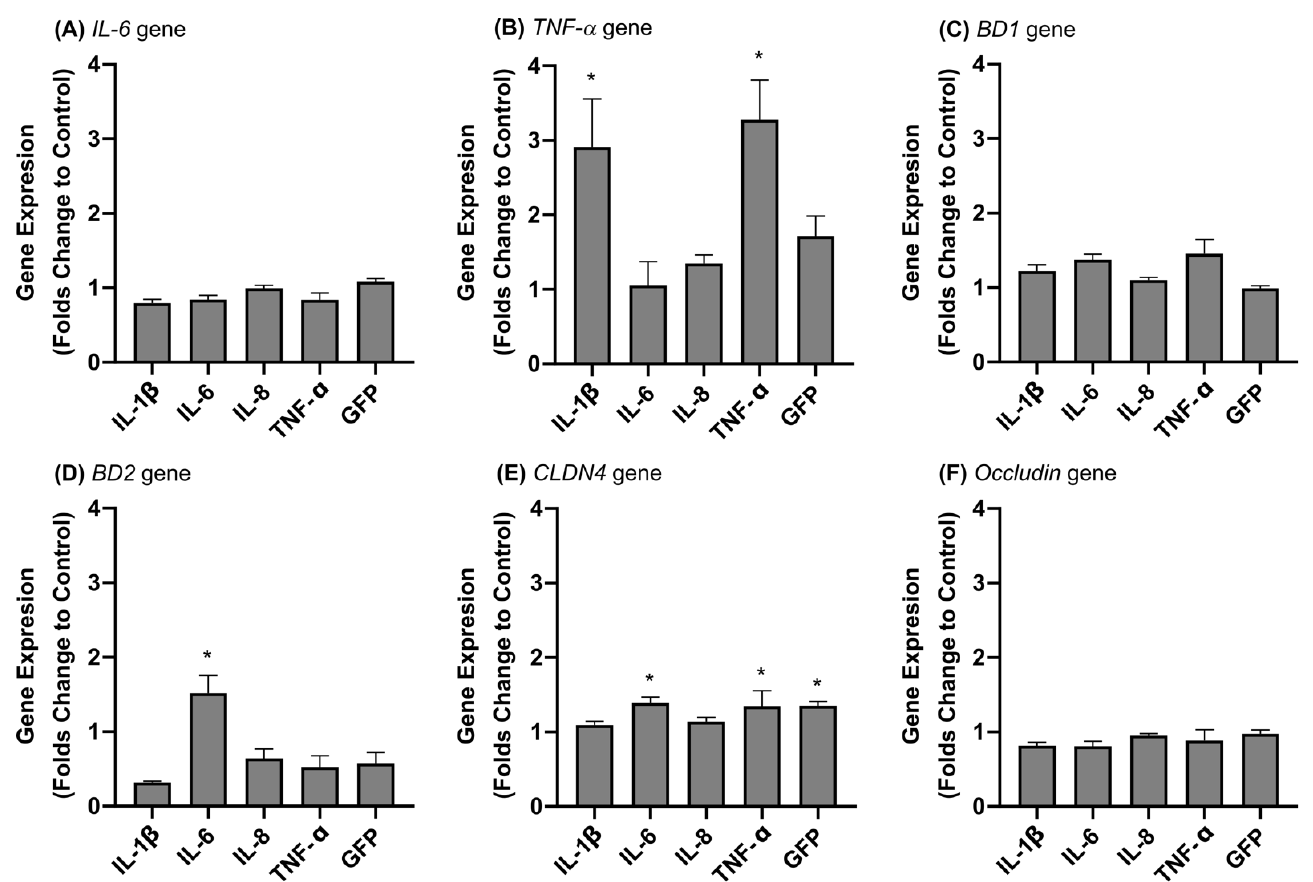
Figure 1. Analysis of gene expressions of ( A ) IL-6, ( B ) TNF- α , ( C ) BD1, ( D ) BD2, ( E ) CLDN4, and ( F ) Occludin, in folds compared to negative control in the IPEC-J2 cell line. Grey bars indicate treatment with 6.25 µ g total protein/mL. GFP IBs and PBS were used as format control and negative inflammatory control, respectively. Error bars indicate the standard error of the mean (SEM). Asterisks show statistically significant differences in expression folds between PBS and treatments. ( A ) p = 0.030; ( B ) p = 0.0004; ( C ) p = 0.0108; ( D ) p = 0.0001; ( E ) p = 0.0006; ( F ) p = 0.5059.